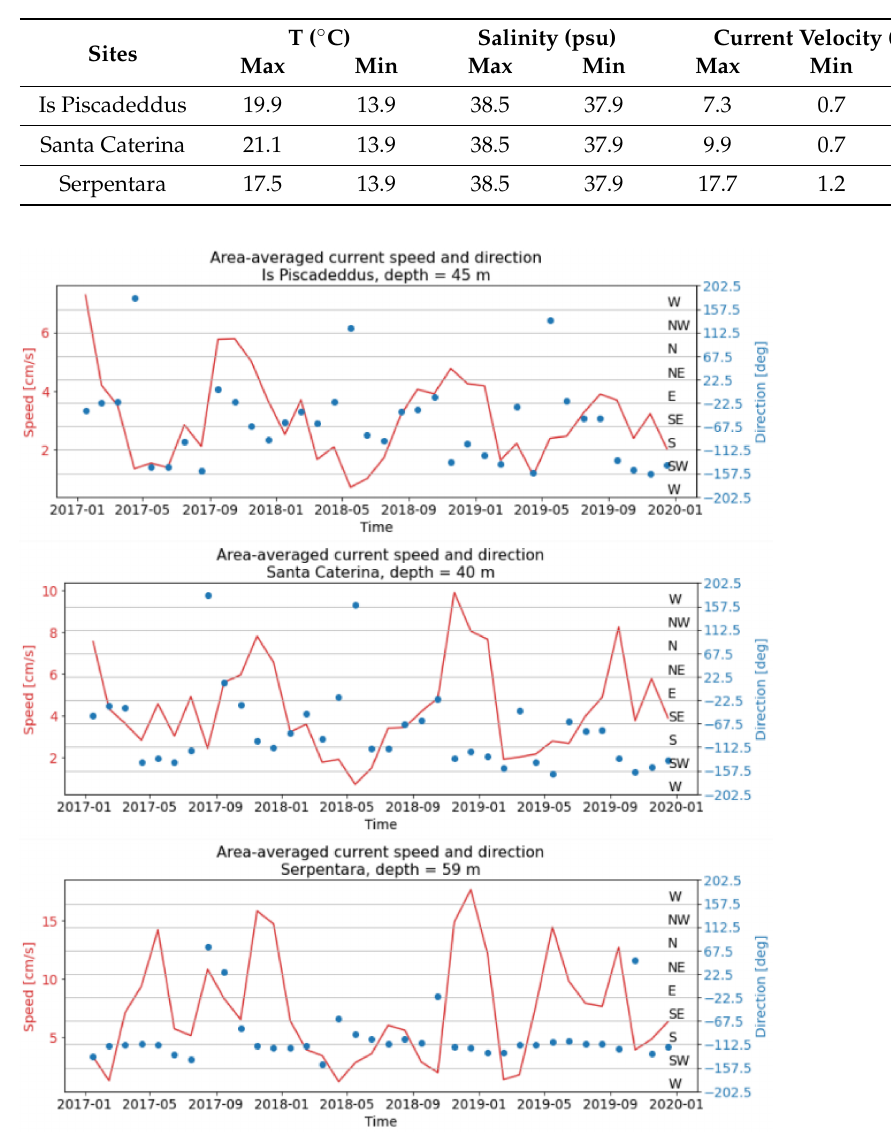
Figure 6. Monthly horizontal current (direction and velocity) obtained from the high-resolution Mediter- ranean Sea MFC physical reanalysis product (MEDSEA) [39], retrieved from the E.U. Copernicus Marine Service Information platform, available at https://resources.marine.copernicus.eu/product-detail/ MEDSEA_MULTIYEAR_PHY_006_004/INFORMATION (accessed on 3 December